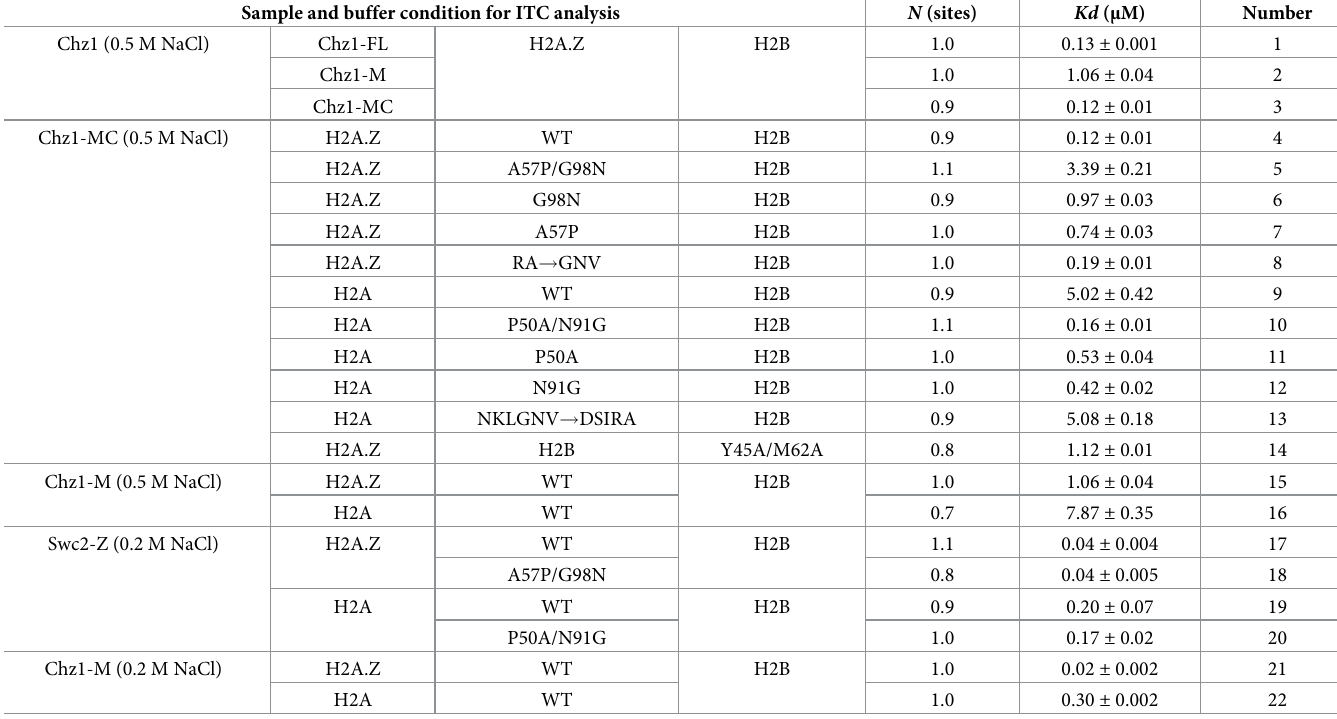
(R ) of 22% (Table 2). The final model contains Chz1 residues 142–153 and is missing resi- free dues 64–141 in Chz1-MC, likely due to the partial degradation of Chz1-MC protein (S2 Fig). Consistent with the aforementioned CSP mapping results, the complex structure showed that Chz1-C interacts with the H2B L1 loop and α 1 and α 2 helices, as well as with the H2A.Z L2 loop (Fig 2B, S2 Fig). The binding of scZB and Chz1-C, which buries a total area of 494 Å 2 (cal- culated by protein data bank in europe, proteins interfaces structures and assemblies [PDBe- PISA] program), is stabilized by both hydrophobic and polar interactions. The side chain of Chz1 residue F151 inserts into the shallow hydrophobic pocket surrounded by Y45, I57 in D148, D149, and D150 form salt bridges and hydrogen bonds with R86 and R90 of H2A.Z as well as S58 and Q59 of H2B (Fig 2C). Because equivalent arginine residues are also present in H2A (i.e., R79 and R83), this interaction is not sufficient to determine H2A.Z specificity (but see below). This histone binding motif contributed by Chz1 engages the Z-B dimer in a con- formation reminiscent of other ancestrally unrelated Z-B and A-B dimer binding proteins, namely, Swr1, Swc2, Anp32e, and suppressor of Ty 16 (Spt16; Fig 2D), and is expected to Table 1. Comparison of the binding affinities measured by ITC. Sample and buffer condition for ITC